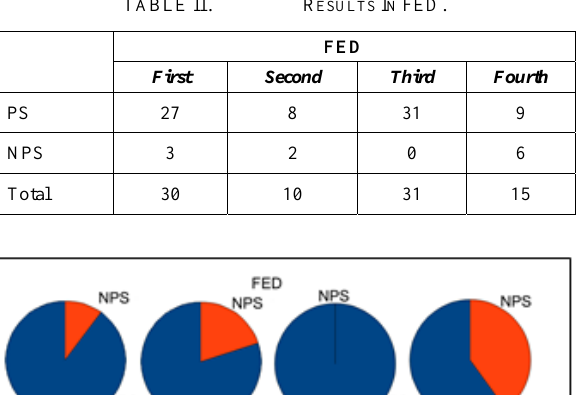
R ESULTS I N FED.